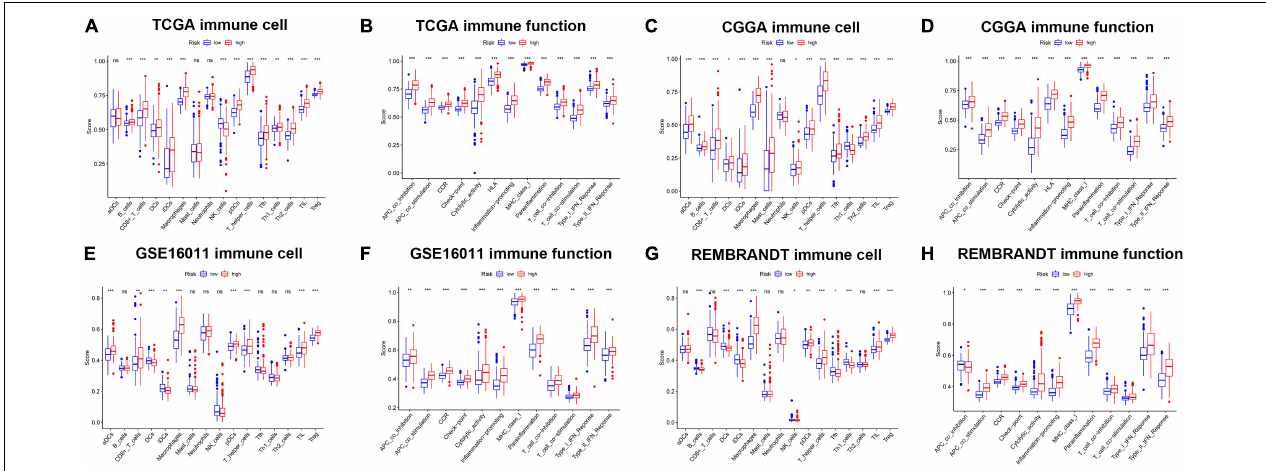
FIGURE 8 | The ssGSEA results of different risk groups in the TCGA cohort (A,B) , CGGA cohort (C,D) , GSE16011 cohort (E,F) , and REMBRANDT cohort (G,H) . The scores of 16 immune cells (A,C,E,G) and 13 immune-related functions (B,D,F,H) were shown in boxplots. Adjusted p were showed as: ns, not significant; * p < 0.05; ** p < 0.01; *** p < 0.001.